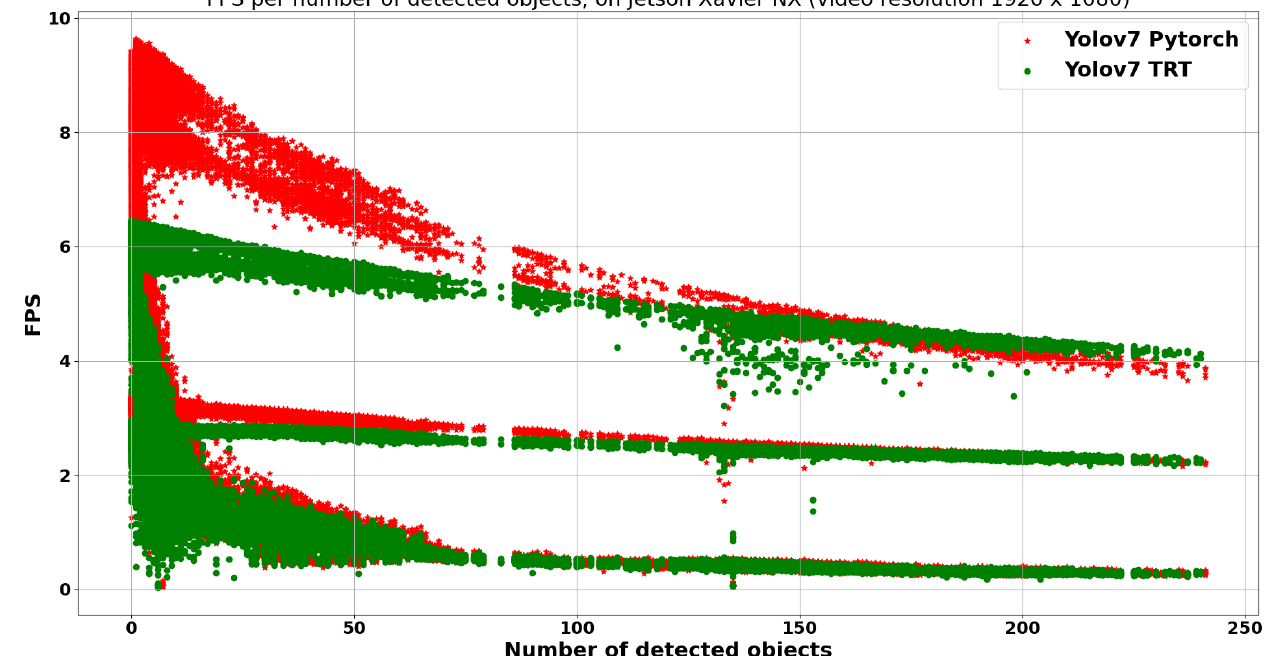
Figure 10. Inference speed (in FPS) per number of detected objects, on Jetson Xavier NX, with an input video resolution of 1920 × 1080, using the PyTorch and TRT version of the YOLOv7 object detection